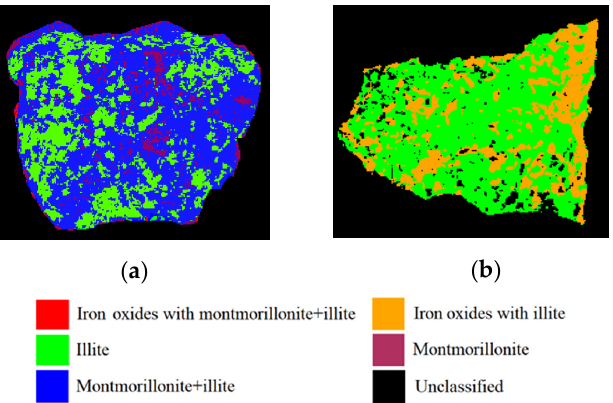
Figure 3. SAM classified SWIR active mineral map for rock samples ( a ) and ( b ), which show mont- morillonite, illite, their mixture together, and with iron